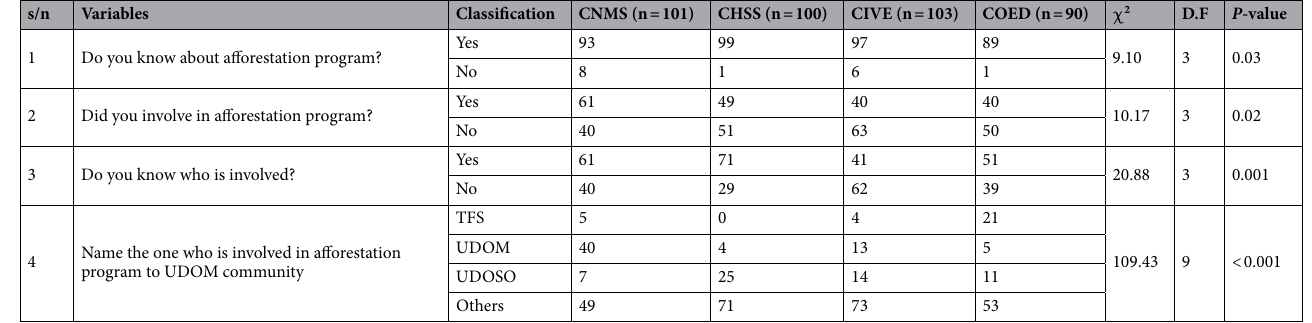
Table 3. Awareness on the afforestation program across the study colleges. P-value , probability value; CNMS , college of natural and mathematical science; CHSS , college of humanities and social science; CIVE , college of informatics and virtual education; COED , college of education; χ 2 , Chi square; D.F ., degree of